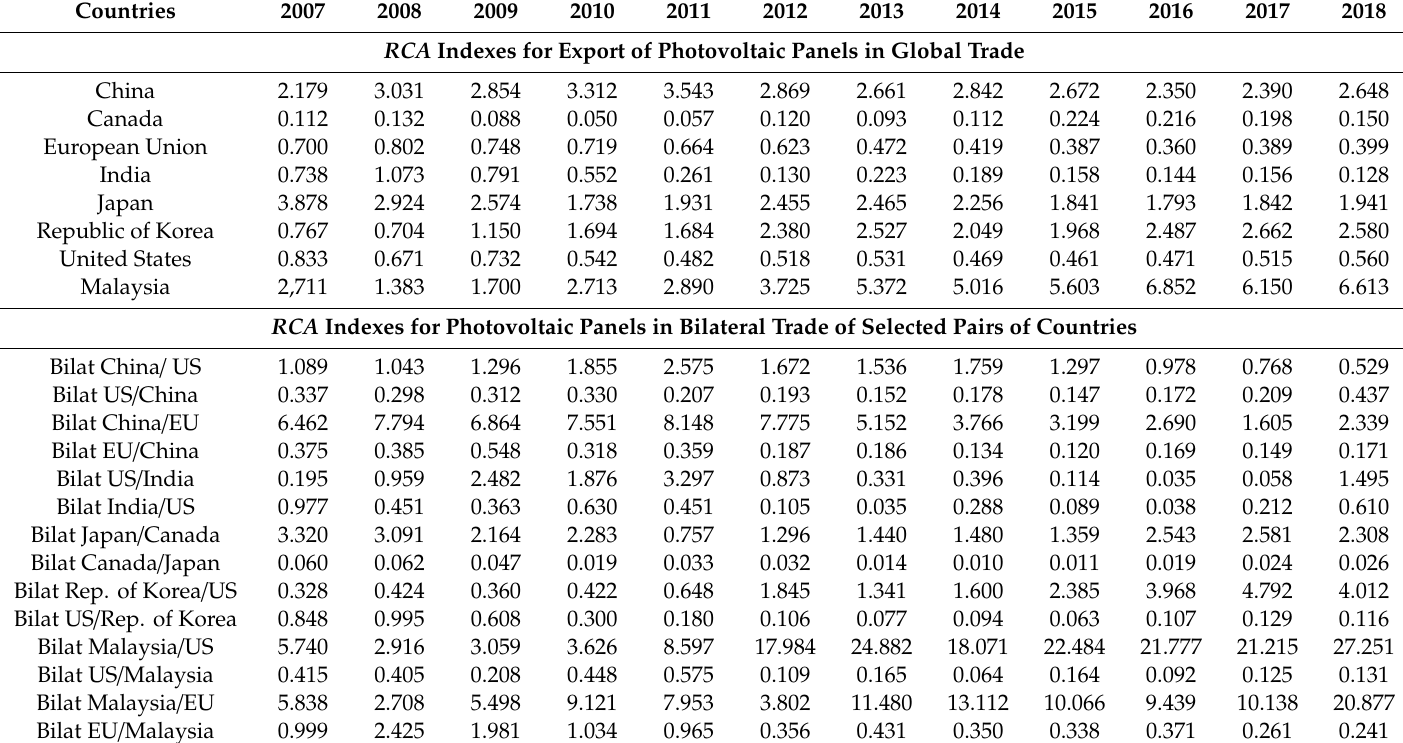
Table 4. RCA and export shares indexes for export of photovoltaic solar panels (covered by the code HS 854140) of selected countries, in their global and bilateral trade, in 2007–2018.